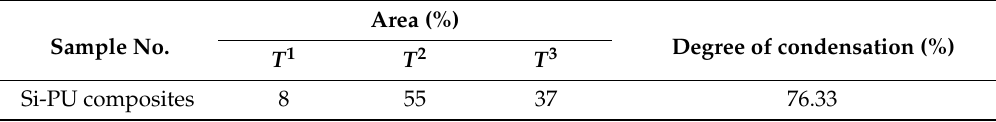
Figure 1. Solid-state 29 Si-NMR spectra of Si-PU composites. Table 1. Area of the t-distribution.